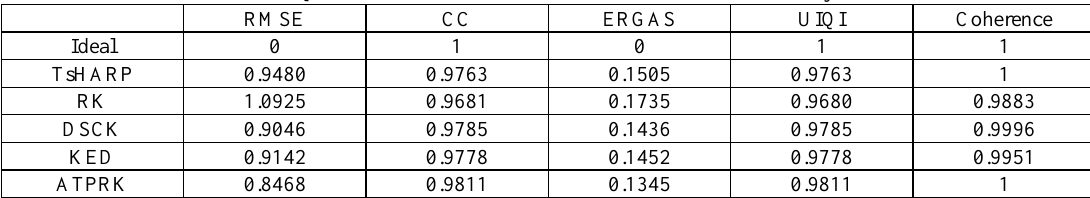
Figure 2. Results of two zoom areas in Fig. 1. (a) 60 m reference. (b) TsHARP. (c) RK. (d) DSCK. (e) KED. (f) ATPRK. Table 1. Quantitative assessment on the methods for the entire study